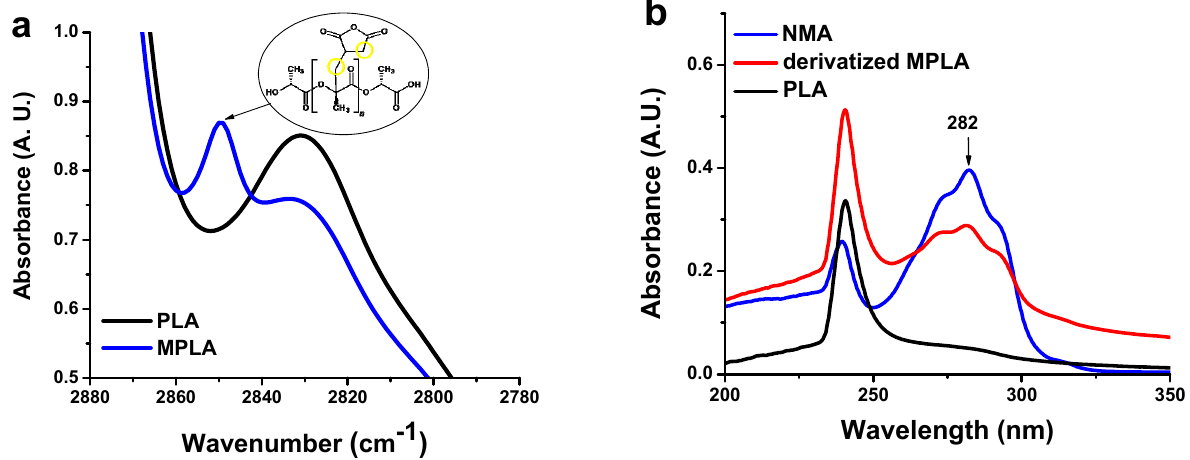
Figure 1. ( a ) FTIR spectra in 2880 − 2780 cm − 1 range, and ( b ) UV spectra of neat PLA and derivatized MPLA. Table 1. GPC data for PLA and MPLA.